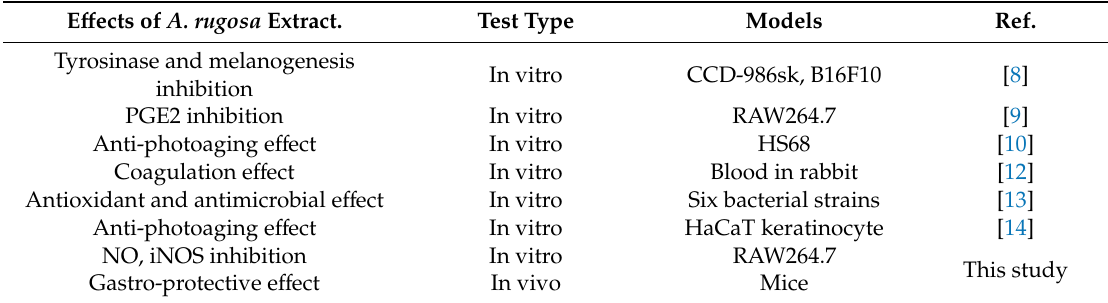
Table 2. Comparison of the e ff ects of A. rugosa extract between previous reports and this experiment. E ff ects of A. rugosa